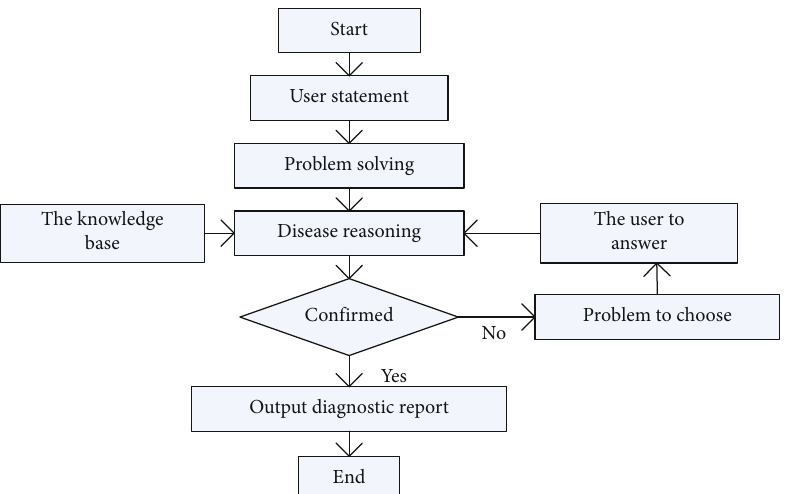
Figure 3: Diagnostic system fl